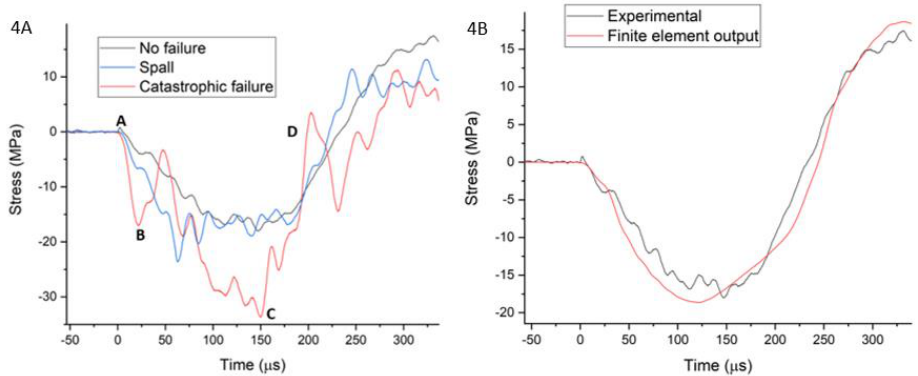
Fig. 4. A . Stress waves recorded for a number of impacts: one that did not result in failure, one that caused a spall, and one that caused catastrophic failure of the cutter. B. Stress wave produced during impact of a cutter that did not fail compared to a finite element simulation at the same speed.